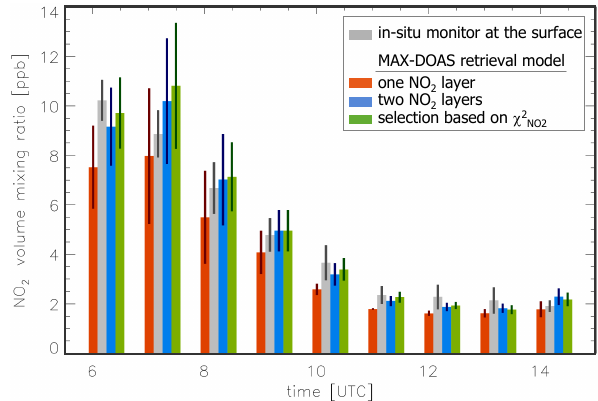
Fig. 15. Diurnal cycle of the NO 2 volume mixing ratio measured with an in-situ monitor at the surface, averaged over five days of the CINDI campaign with cloud free mornings (Sect. 5.2.2), and average NO 2 volume mixing ratio derived by the MAX-DOAS, for the one and two NO 2 layer retrieval models, and for a composite retrieval approach where the choice between the one and two NO 2 layer retrieval model is based on the lowest value of χ 2 vertical lines indicate the root mean square , see text. NO2